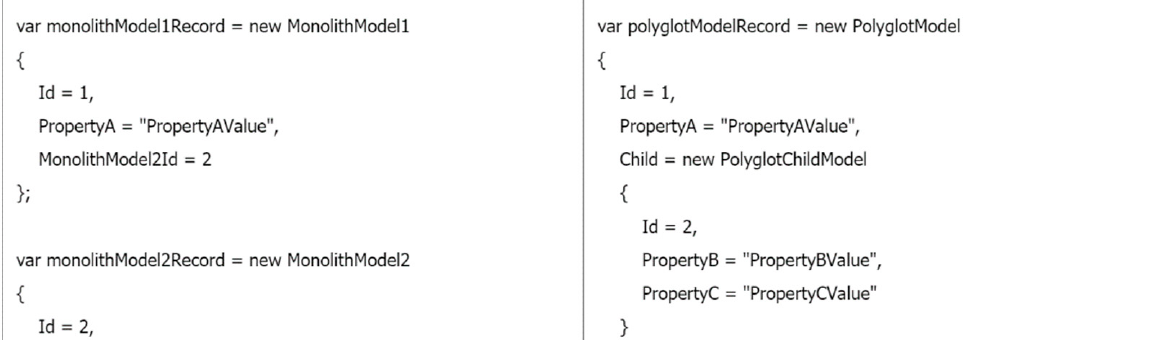
Figure 9. The test case execution.